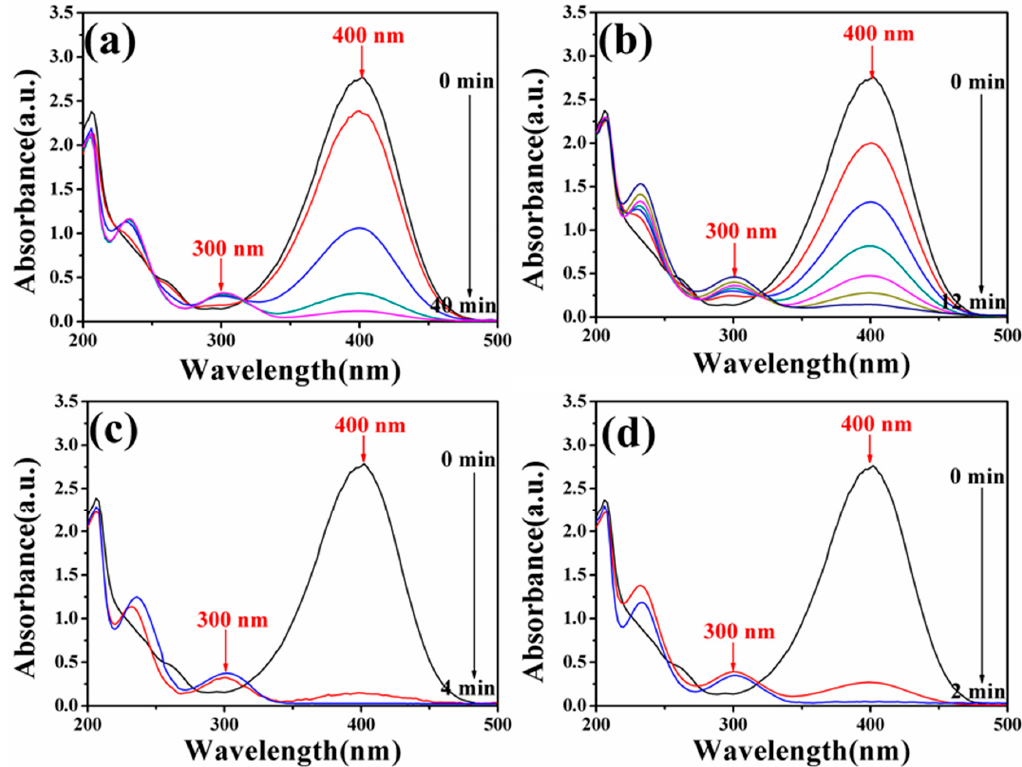
Figure 8. UV-Vis absorption spectra of 4-NP after reduction catalyzed by Fe 3 O 4 -Au 5 mL ( a ), Fe 3 O 4 -Au 20 mL ( b ), Fe 3 O 4 -Au 40 mL ( c ) and Fe 3 O 4 -Au 60 mL ( d ).